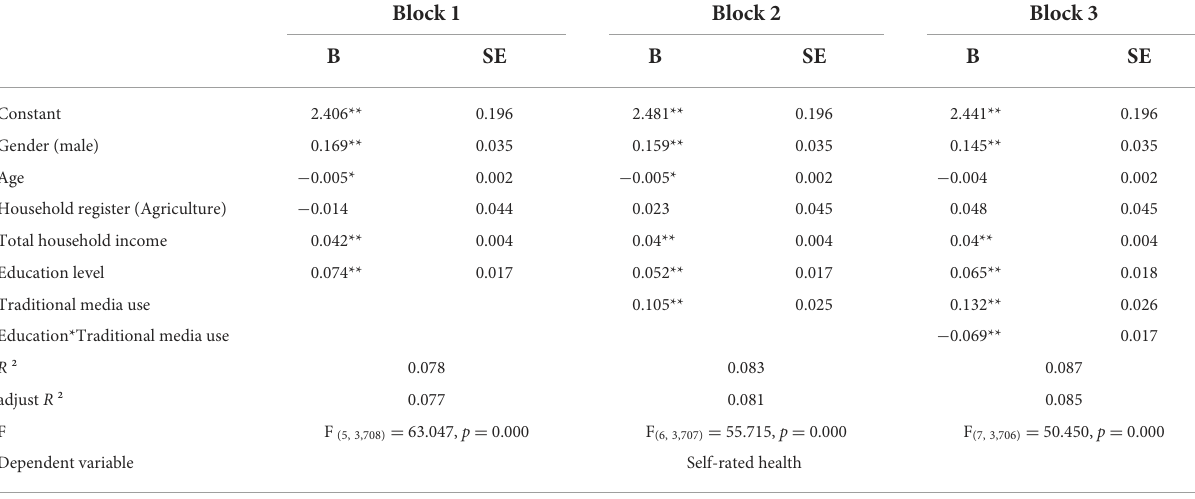
TABLE 8 Results of hierarchical regression analysis a.